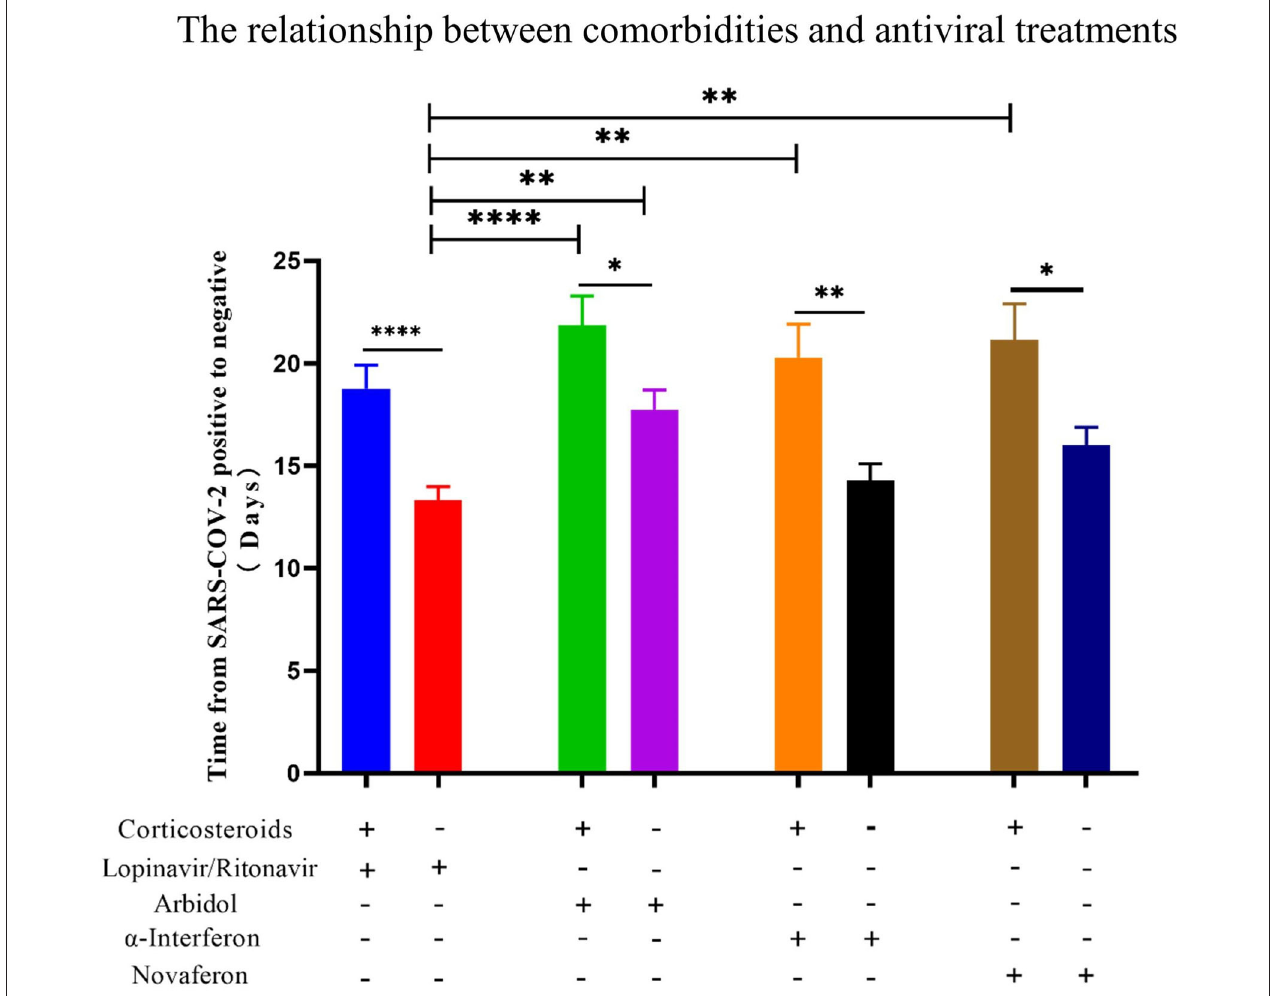
FIGURE 7 | The relationship between the use of corticosteroids and the conversion time from real-time PCR (rtPCR) positive to negative during antiviral treatment. Patients were divided by used antiviral drugs and corticosteroids use. Patients treated with corticosteroids showed in all groups a significantly longer conversion time from rtPCR positive to negative. Data are presented as mean ± SEM. The significance was determined as * p < 0.05, ** p < 0.01, and **** p <